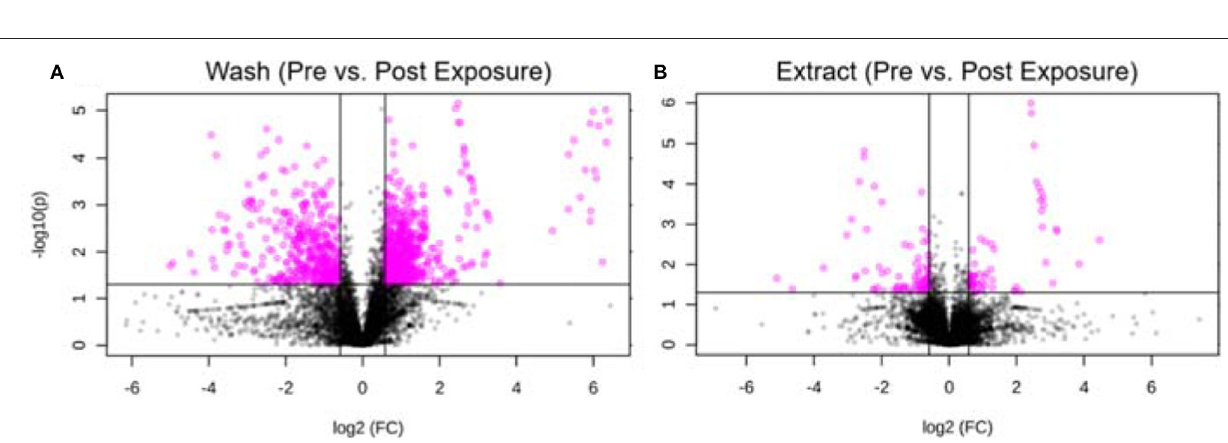
Frontiers in Chemistry |